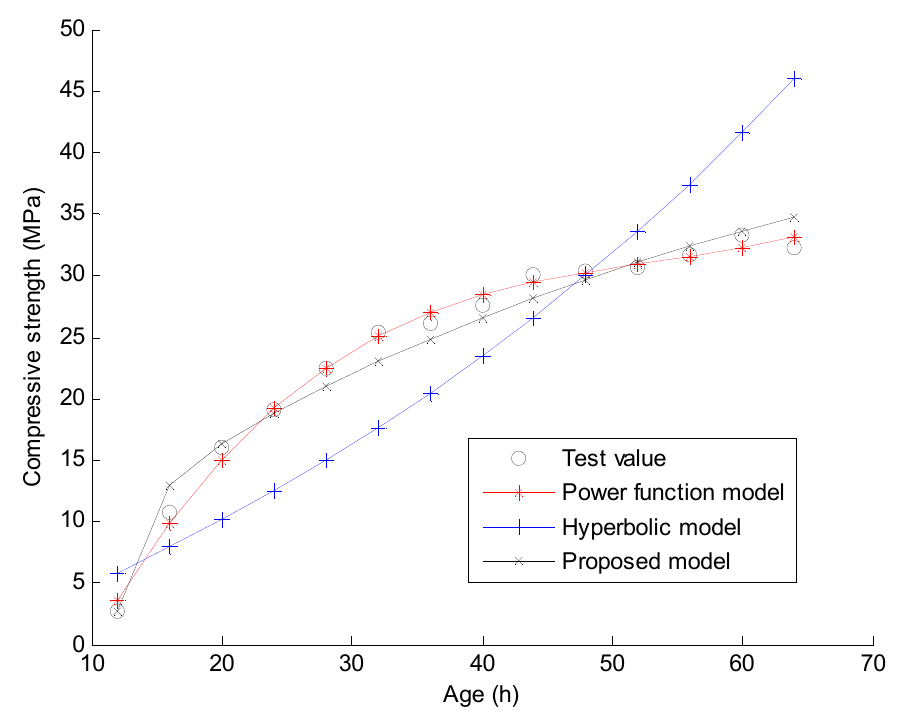
Figure 3. Curve fitting results using the three models for C40 under natural curing.